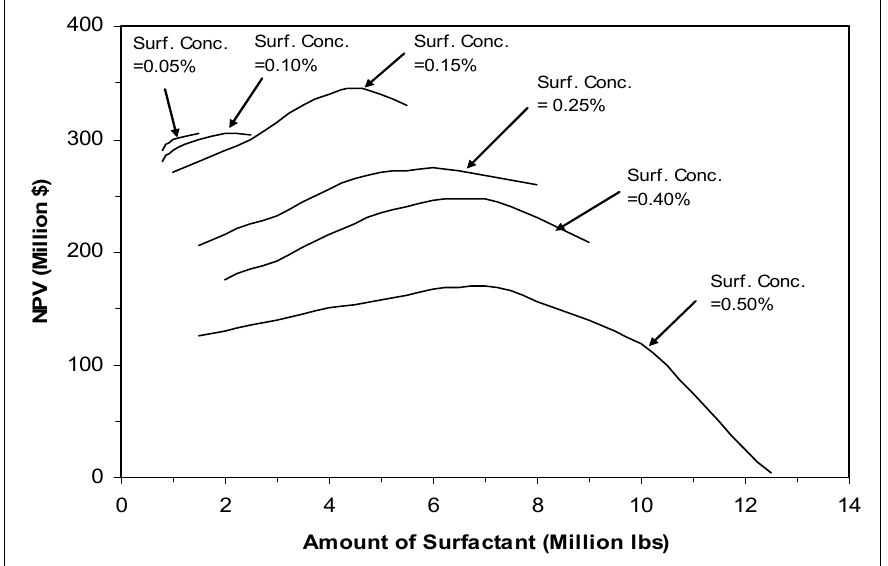
Figure 3. Variation of NPV with the amount of surfactant used for different surfactant concentrations (polymer conc. = 2800